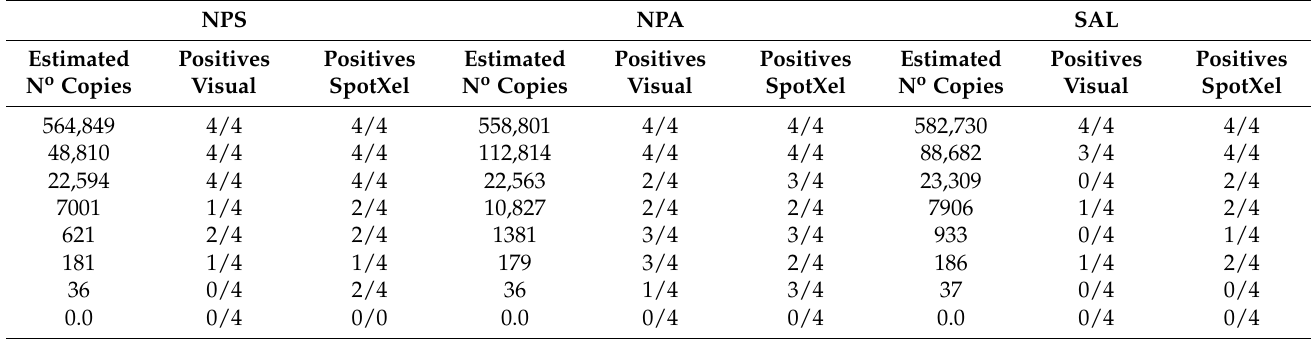
Table 1. Detection limit of the rapid LAMP